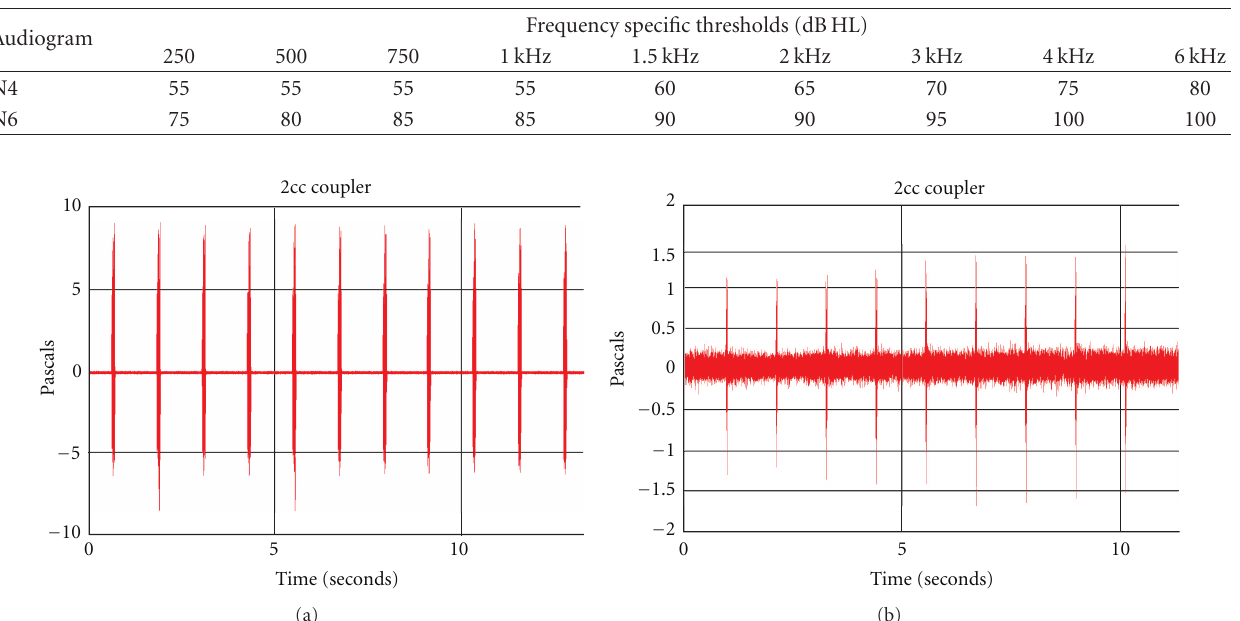
Table 2: Frequency specific thresholds of N4 and N6 standard audiograms [39]. The threshold at 750Hz for the N6 audiogram was originally 82.5dBHL but had to be rounded to 85 dBHL to allow input into the verification system.